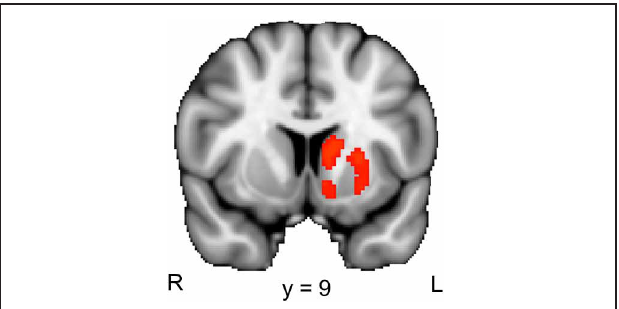
FIGURE 4 | Striatal activation associated with the reduction of perceptual uncertainty. The colored regions were more active when the second picture in a trial reduced the perceptual uncertainty induced by the preceding picture (i.e., the second picture in the B–C corresponding condition) than when the second picture did not reduce the perceptual uncertainty induced by the preceding picture (i.e., the second picture in the B–C unrelated condition). R, right; L, left. The displayed activations are the cluster-corrected Z statistic maps ( p < 0 . 05) from the striatal ROI analysis, which were overlaid onto the standard MNI